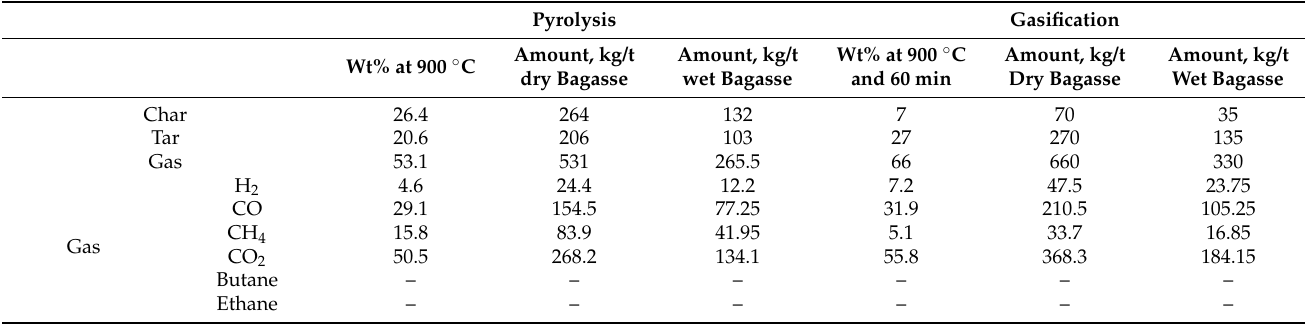
Table 30. Amount of char, tar and gases produced during the pyrolysis and gasification processes.